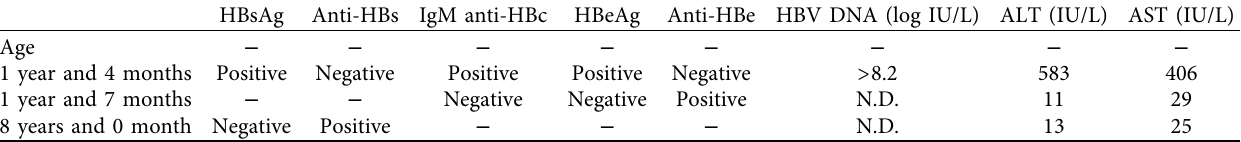
Table 1: Laboratory results of the first patient.